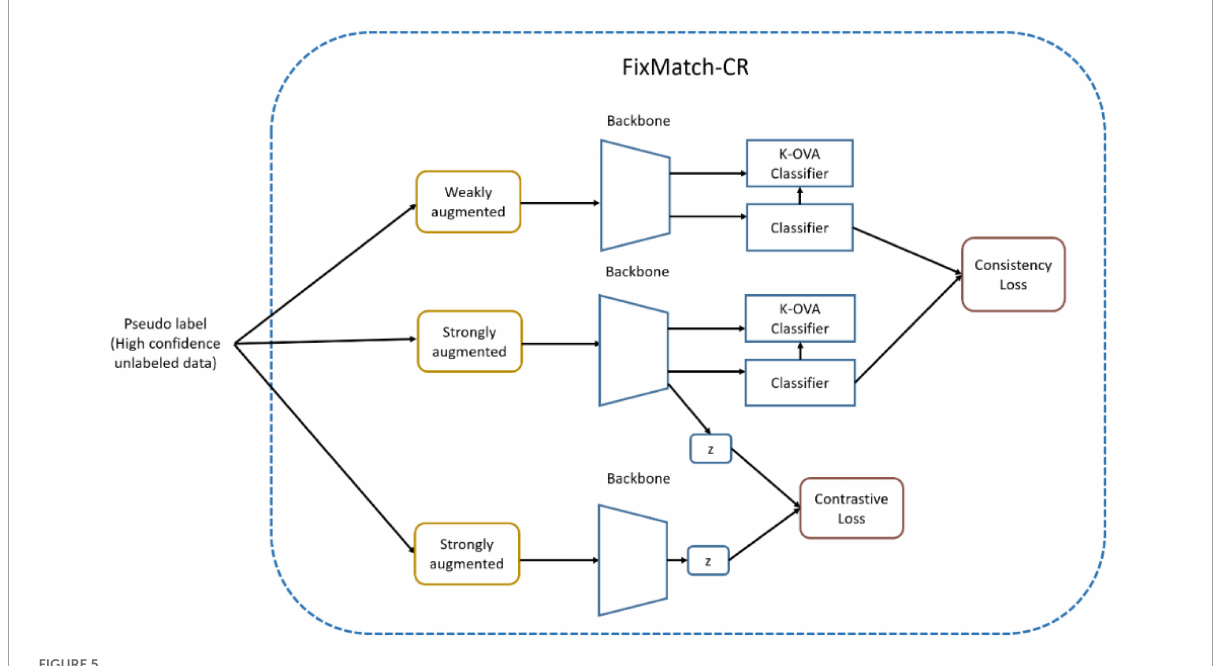
FIGURE5 FixMatch with contrastive regularization in OpenMatch.